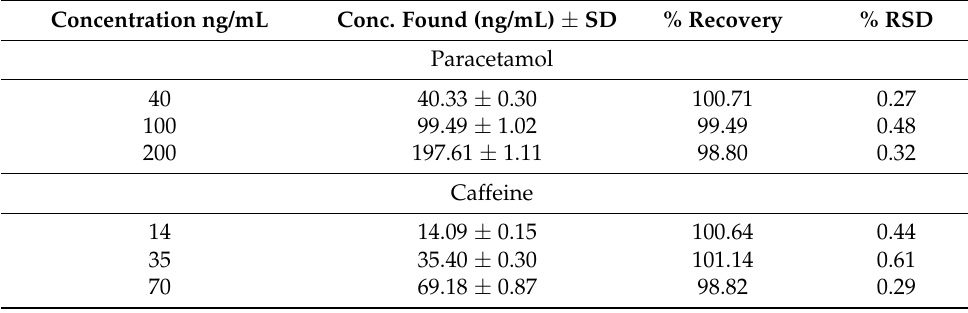
Table 2. Accuracy of PCM and CAF contents.